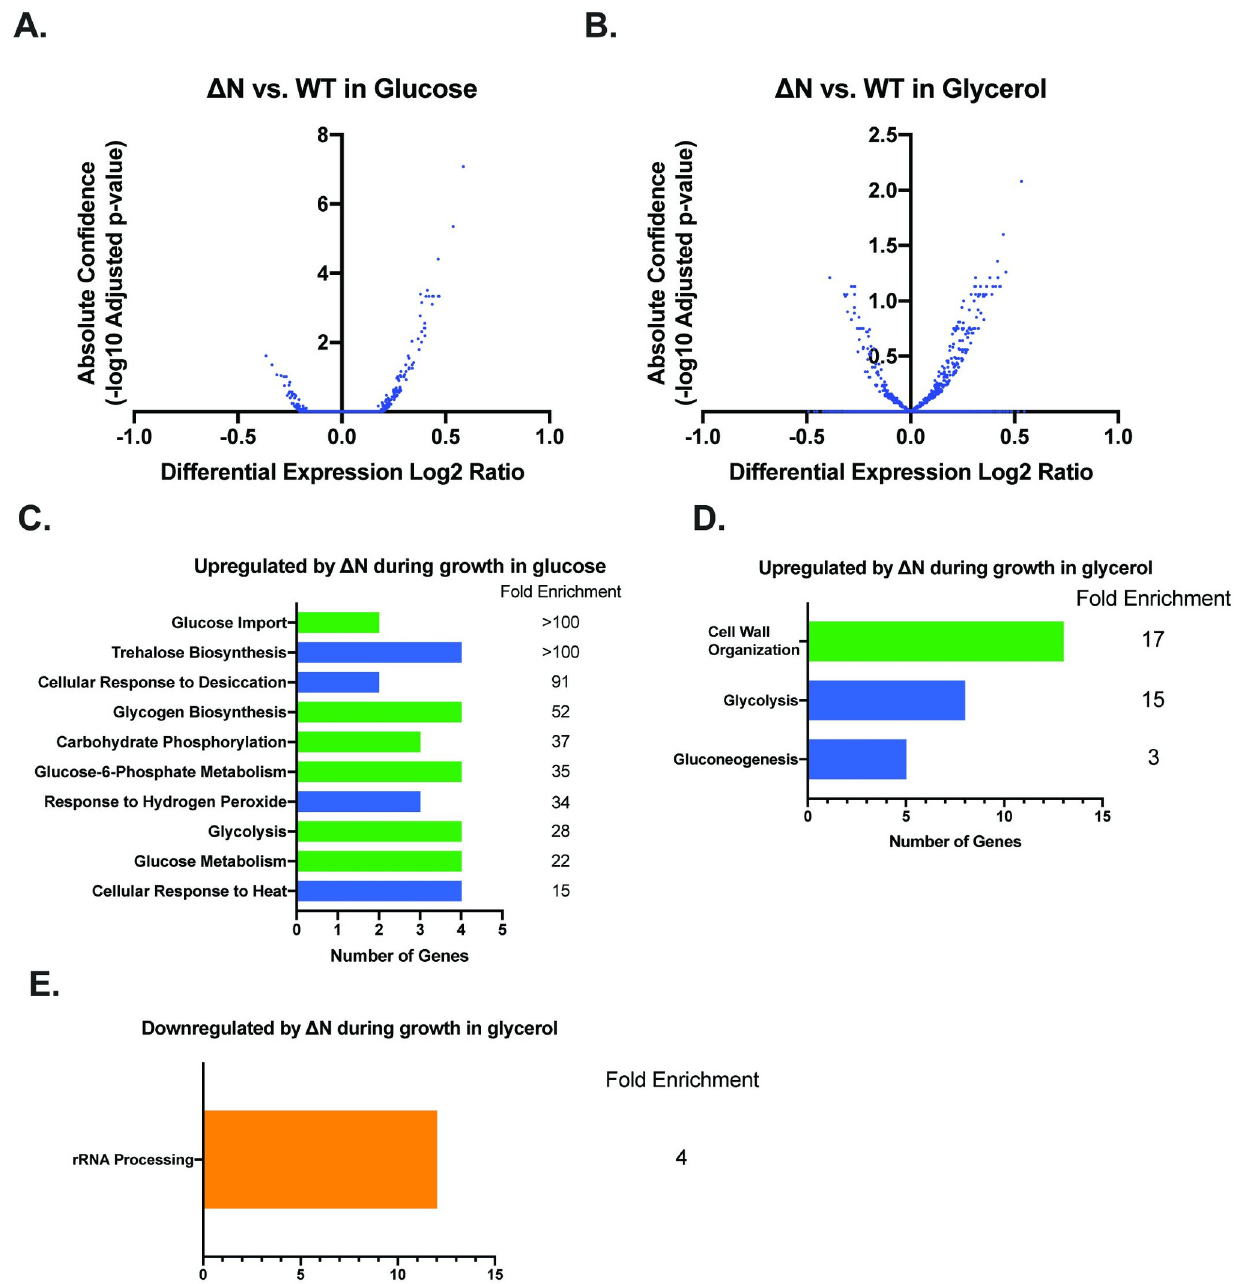
Fig 3. The polyN domain of Azf1p plays a subtle role in transcription. A) Volcano plot showing genes that are differentially expressed in Δ N compared to WT in glucose. B) Volcano plot showing genes that are differentially expressed in Δ N compared to WT in glycerol. C) GO Enrichment Analysis of upregulated genes with a log2 ratio of 0.30 or more in Δ N in glucose compared to WT. Fold enrichment is indicated to the right of each bar. Processes related to environmental stress tolerance are shown in blue, and processes related to carbon metabolism and storage are shown in green. D) GO Enrichment Analysis of upregulated genes with a log2 ratio 0.30 or higher in Δ N in glycerol compared to WT. Fold enrichment is indicated to the right of each bar. Processes related to environmental stress tolerance are shown in blue, and processes related to carbon metabolism and storage are shown in green. D) GO Enrichment Analysis of upregulated genes with a log2 ratio –0.30 or lower in Δ N in glycerol compared to WT. rRNA processing is the only process for which this set of genes is statistically significantly enriched (4-fold enrichment).